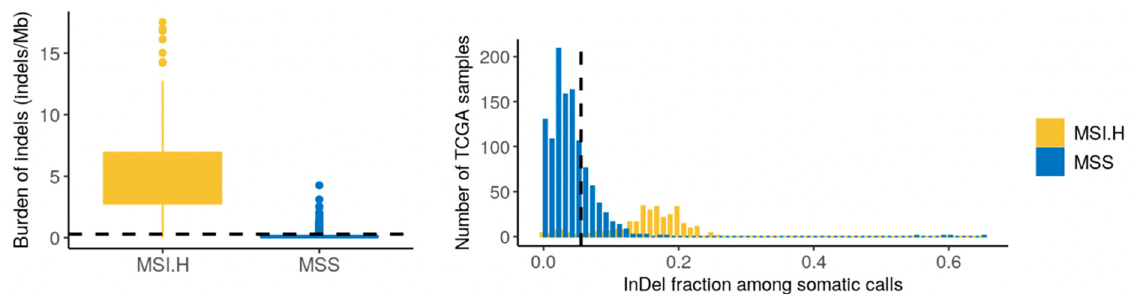
Figure 4. Assessment for the potential microsatellite instability (MSI) of the tumor case through a somatic variant comparison with TCGA samples with a verified MSI status (as detected with a PCR-based assay of mono- and dinucleotide repeats). The value for the prostate tumor case is depicted by a black, dashed line. MSS = microsatellite stable tumors (TCGA) and MSI.H = microsatellite instable tumors (TCGA).